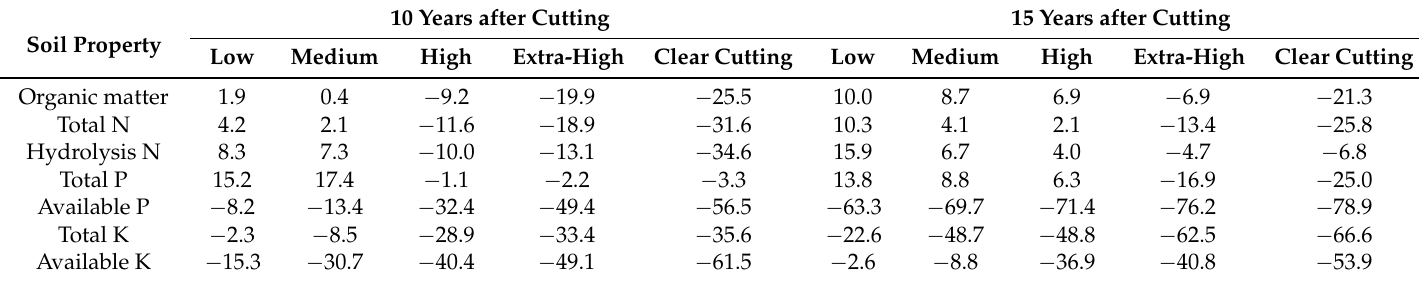
Table 6. Percentage changes in soil chemical properties due to different cutting intensities relative to